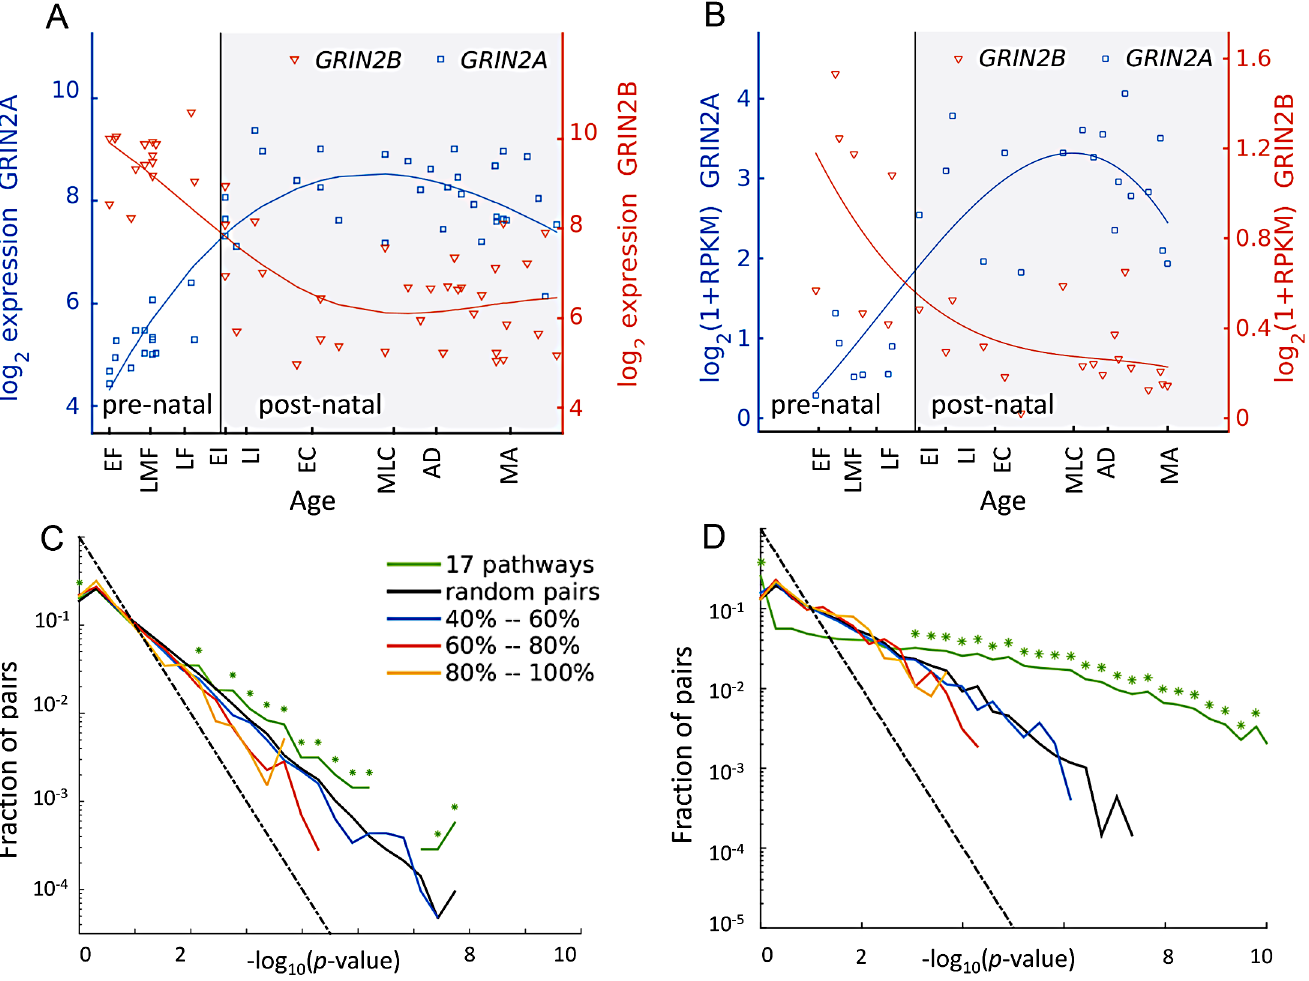
Fig 1. Condition-dependent variants of the NR2 subunits of human NMDA receptors. (A) The expression profiles of GRIN2A and GRIN2B, the two genes encoding NR2A and NR2B in human cerebellum (CBC). The expression level of GRIN2B (NR2B) declines during prenatal and early childhood, while the expression level of GRIN2A (NR2A) rises during that period. (B) Same as A for RNA-seq Brainspan data [34]. (C) Distribution of correlation values across various gene pairs ad regions in the data of [32]. The curve marked ‘ pathways ’ corresponds to the all pairs from the brain-related keg pathways. Curves marked with percentages correspond to sets of gene pairs whose sequence overlap is in the designated range, based on biomart overlap measure. Asterisks mark bins of the histogram where the observed number pairs in the 17 pathways is significantly larger (permutation test, p < 10 – 3 ) from that obtain at random. Dashed line shows the fraction expected at random. (D) Same as C for RNA-seq Brainspan data